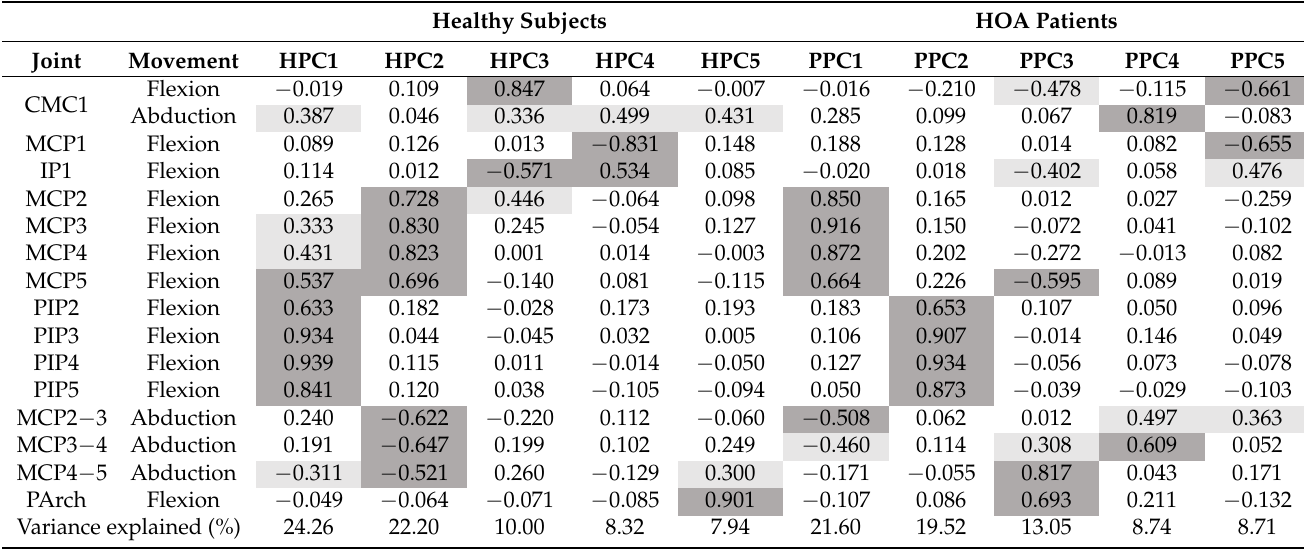
Table 2. Loadings of resulting PCs in the PCA performed on each sample. H and P stand for healthy subjects and HOA patients, respectively. For easier interpretation, loadings greater than 0.3 (weak) and 0.5 (strong) are highlighted in light and dark grey, respectively, similarly as in [42]. The last row shows the variance explained by each PC.